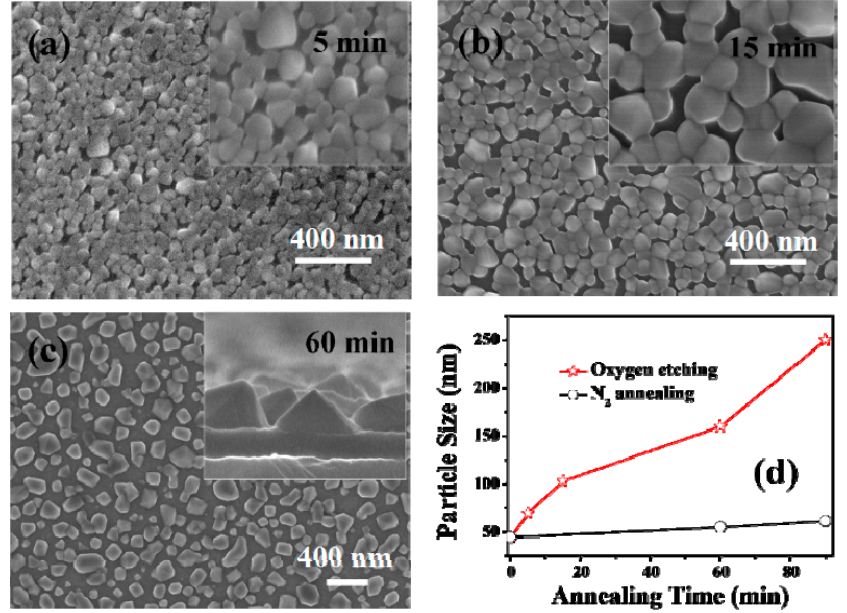
Figure 4. FESEM morphologies of the VO 2 films treated with 0.12 kPa oxygen injection at 540 ◦ C for different times. The annealing times were 5 min ( a ), 15 min ( b ), and 60 min ( c ). The relationship between the particle size and annealing time for N 2 annealing and oxygen assisted annealing is shown in ( d ). The particle size for each film was obtained by randomly counting 100 particles in the SEM images. The insets in ( a , b ) show the high magnification surface images for the corresponding sample, and the inset in ( c ) shows the enlarged cross-section image of the sample.